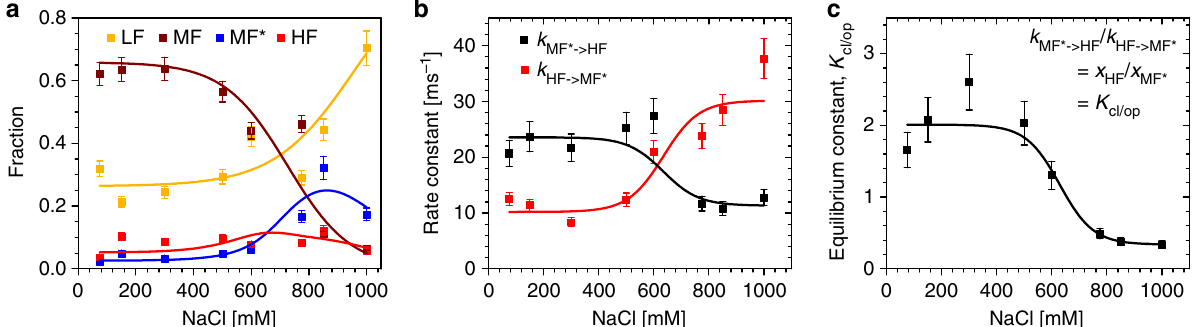
Fig. 5 Kinetic parameters of I β I α -wt nucleosomes as function of NaCl concentration. The dependence of fractions of the four FRET species on the NaCl concentration were determined from single molecule measurements of 20 pM I β I α -wt nucleosomes by dynPDA. The transitions are described by weighted i = LF, MF, MF*, and HF. fi ts to a sigmoidal function (Supplementary Note 5, Supplementary Equation 36). a Salt-dependence of the static fractions x i of Intact nucleosomes (MF) are dominant at low salt concentrations but decrease rapidly above 600 mM NaCl in favor of LF and MF*. The fraction of nucleosomes that was found in a dynamic transition between MF* and HF peaks around 800 – 900 mM NaCl. Global fi t with x MF* = (1 – x LF – x MF )/(1 + K cl/ x = (1 – x – x K + K K fi t in c . c = 725 ± 25 mM, c op ) and HF LF MF )* cl/op /(1 cl/op ). The salt-dependent equilibrium constant cl/op was obtained from the 1/2 (MF) 1/2 (LF) = 957 ± 41 mM. b Salt-dependent kinetic rates for the MF* ⇄ HF transition. Transitions from MF* to HF are suppressed at higher NaCl concentrations, while the back reaction from HF to MF* is promoted by increasing salt. Global fi t with c 1/2 = 635 ± 60 mM. c Equilibrium constant K cl/op as obtained from ¼ k = k ¼ x = x the rates in b : K . c 1/2 (K cl/op ) = 629 ± 34 mM. Error bars are standard errors from at least three cl = op MF (cid:2) ! HF HF ! MF (cid:2) HF MF (cid:2)